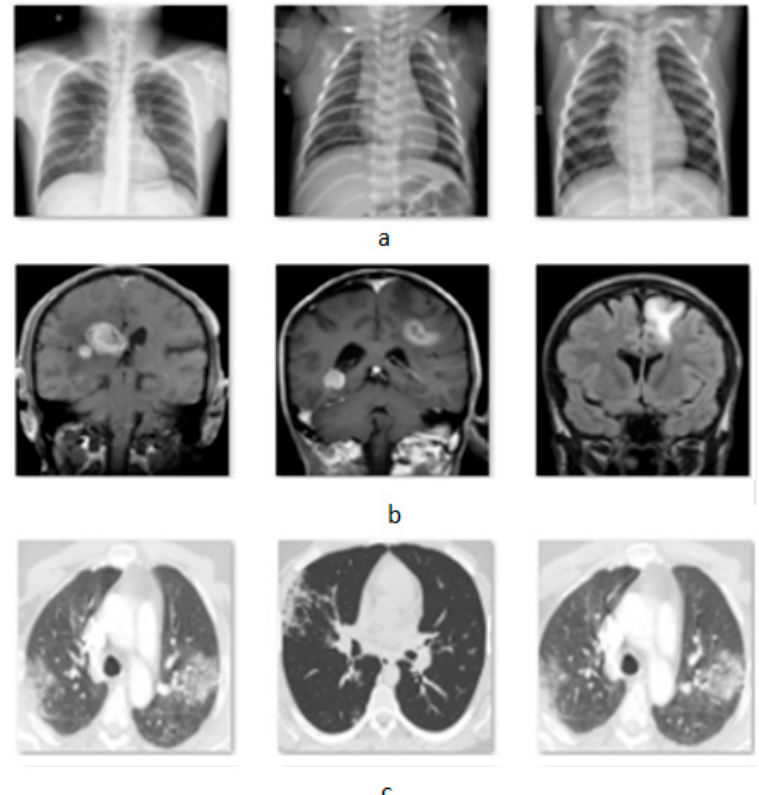
Figure 2. Images from three datasets, ( a ) X-rays, ( b ) MRIs, and ( c ) CT-Scans.